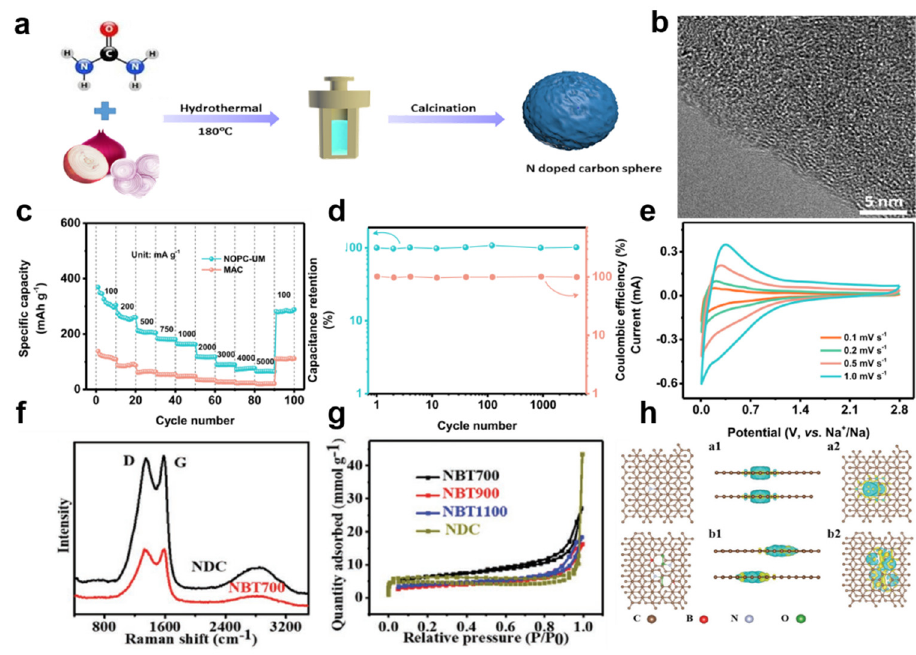
Figure 7. ( a ) Schematic illustration of the synthesis of N-doped carbon sphere. ( b ) TEM image of carbon sphere. Reprinted with permission from Ref. [111]. Copyright 2020 Elsevier. ( c ) The rate performance of NOPC and MAC anodes at various current densities. ( d ) Cycling stability of hard carbon anode measured at 1000 mA g − 1 . ( e ) CV curves measured of hard carbon anode. Reprinted with permission from Ref. [5]. Copyright 2020 Elsevier. ( f ) The Raman spectra of NDC and NBT. ( g ) The N 2 adsorption–desorption isotherms at different temperature. ( h ) The N doping model for NDC and N, B co-doping model for NBT, respectively. Reprinted with permission from Ref. [83]. Copyright 2021 Wiley-VCH.